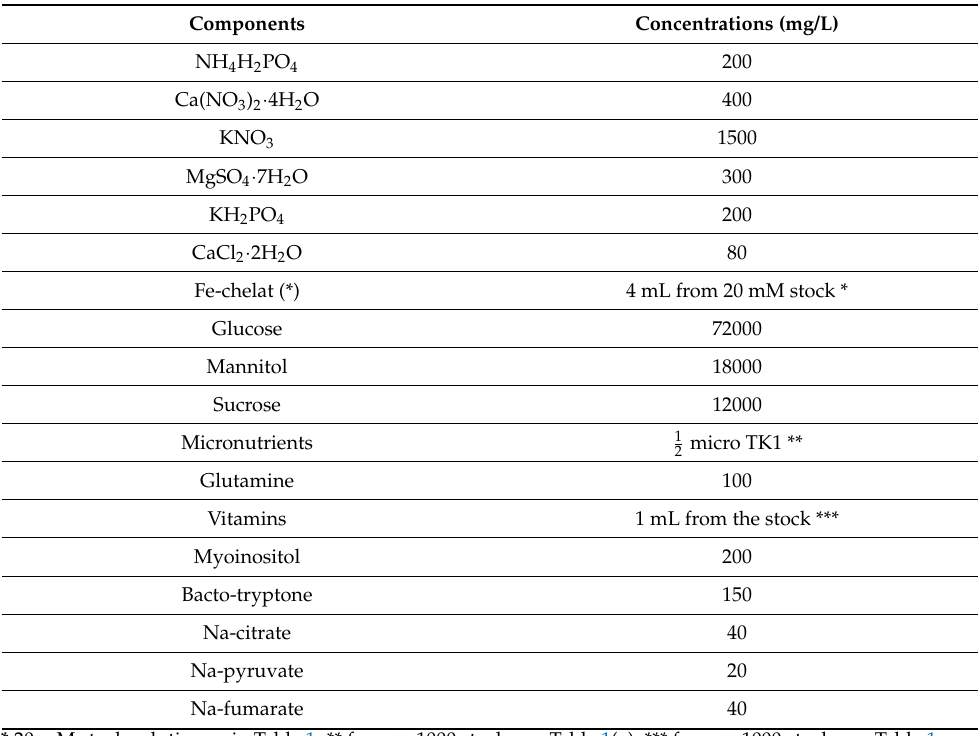
Table 2. TK30 medium for protoplasts